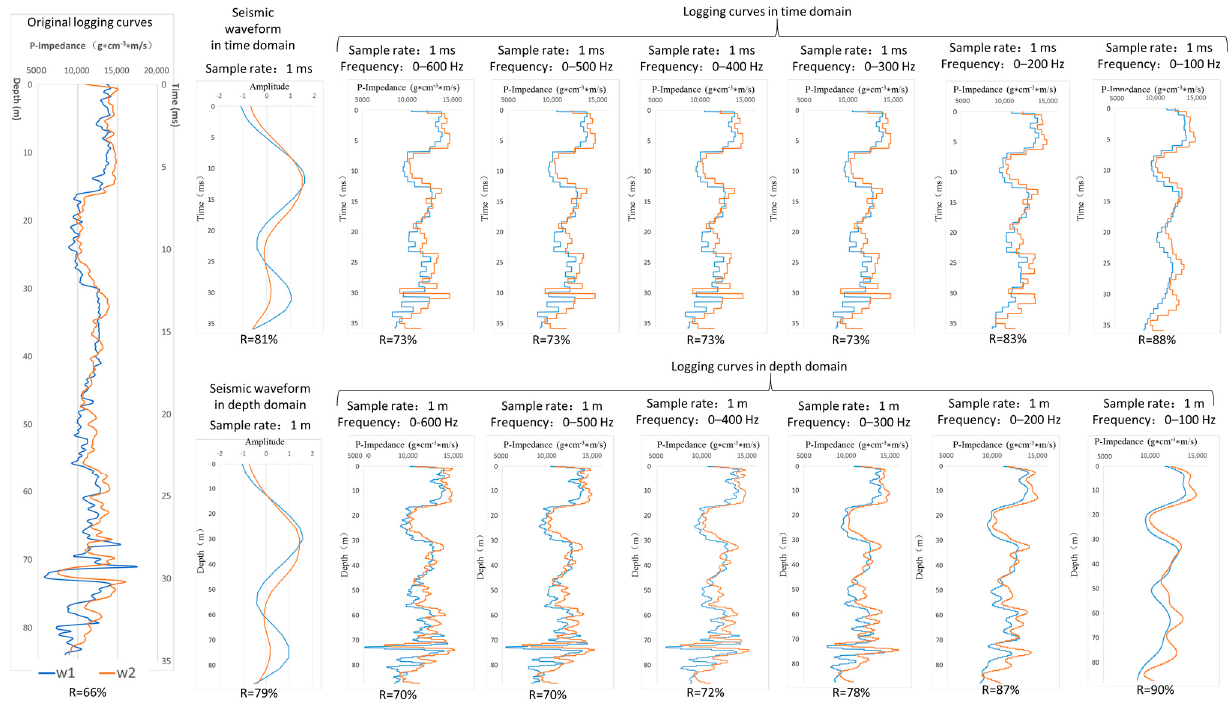
Figure 2. Logging curve comparison of two wells (w1 and w2) with similar seismic waveform at different frequency bandwidths.